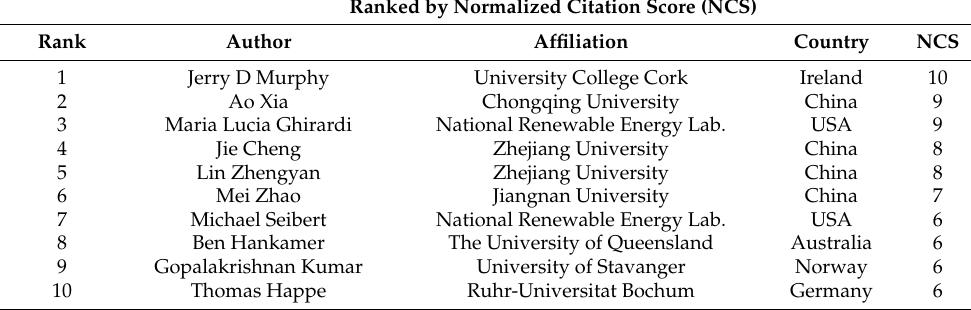
Table 4. Top authors ranked by NCS.